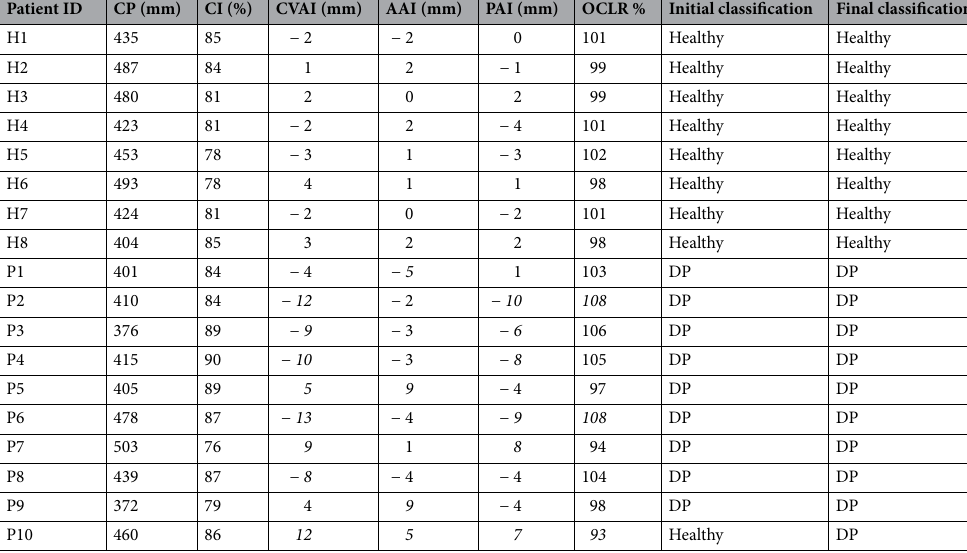
Table 1. Deformation parameters and classification for the patients. In italic values outside the normal